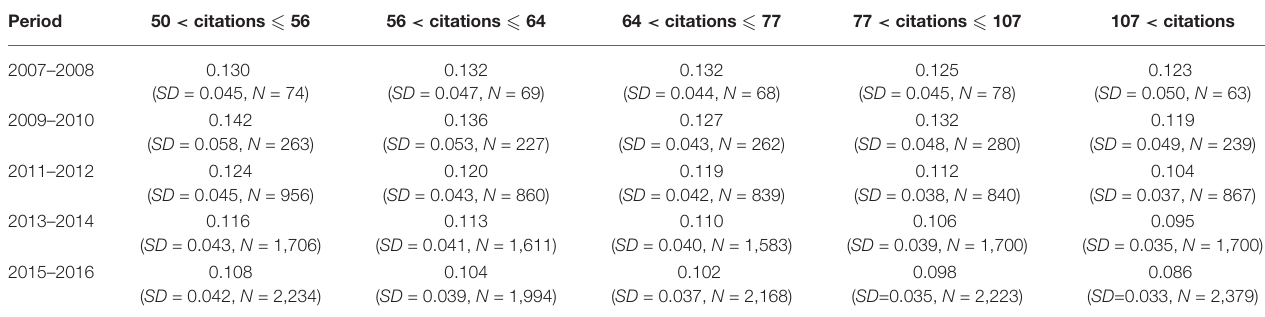
TABLE 3 | Temporal distribution of the change scores of cited articles from 2007 to